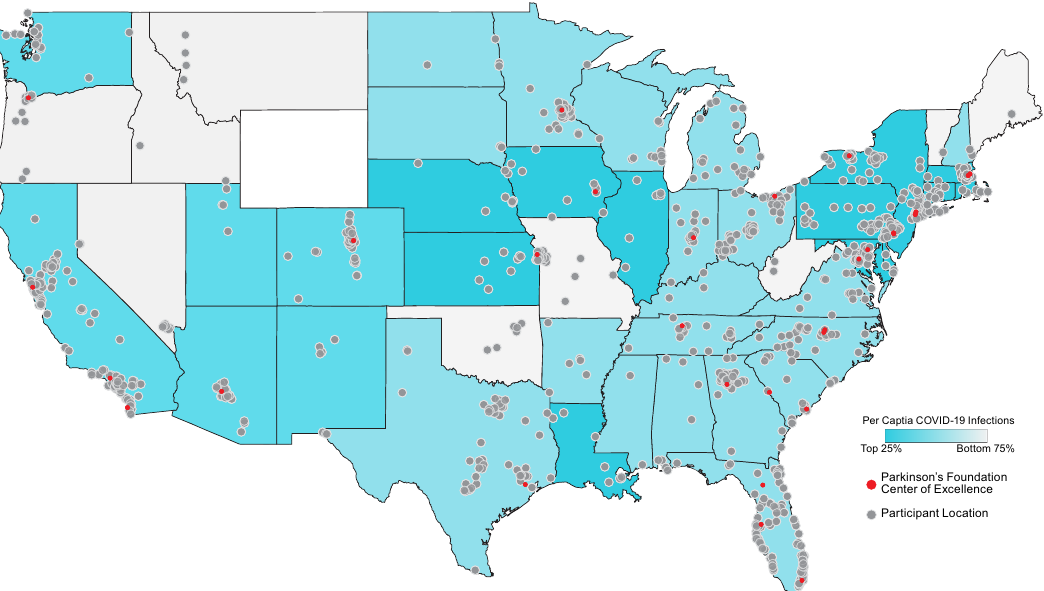
Fig. 1 Participant representation by COVID-19 per capita infections as of May 27, 2020. US geographic location strati fi ed by cumulative numbers of con fi rmed COVID-19 cases per capita (per 100,000) within that state as of May 27th, 2020; representing a total of 1,292 participants. Highest 25th percentile, >570 cases per 100,000; between 25th and 75th percentile, 200 – 750 cases per 100,000; lowest 75th percentile, <200 cases per 100,000. Darker states indicate higher per capita infections of COVID-19. Gray dots re fl ect survey participant locations. Red dots re fl ect the location of a Parkinson ’ s Foundation Center of Excellence, a medical center specializing in the care of people with Parkinson ’ s